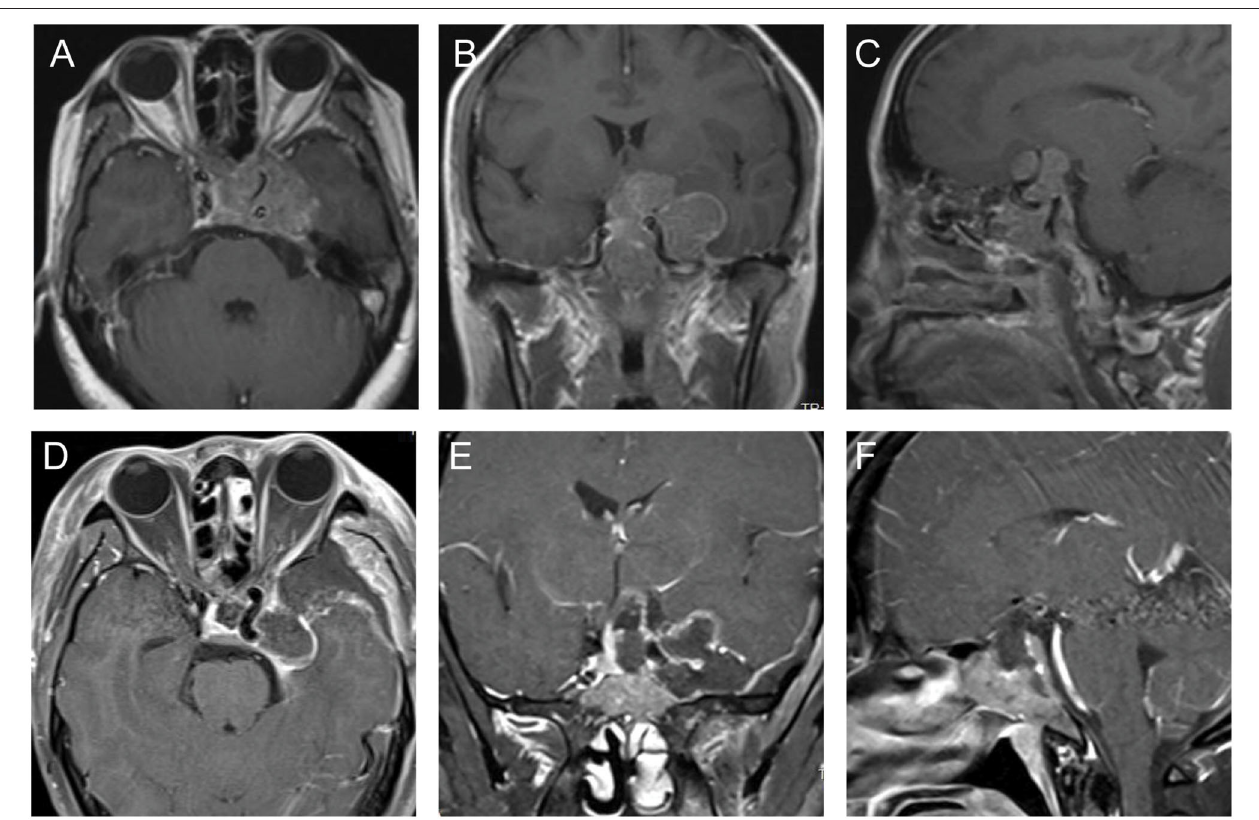
FIGURE 3 | The preoperative and postoperative MRI imaging of case 3. (A–C) Preoperative MRI showed the tumor involved intrasellar, suprasellar region, sphenoid sinus, and the left CS. The intracavernous ICA was completely encapsulated by this tumor. (D–F) Postoperative MRI showed the most of the tumor was resected and part of the tumor remained in the sphenoid